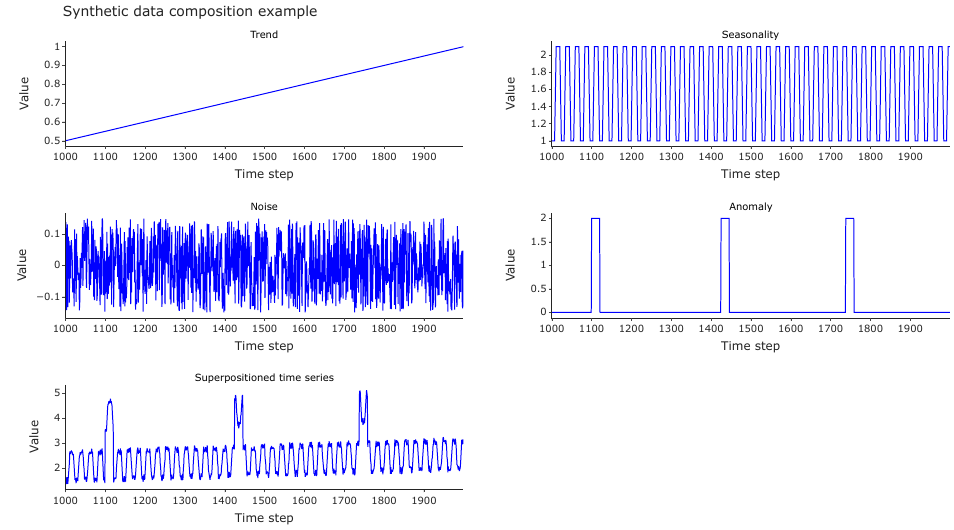
Figure 4. Example of a synthetic time series. Table 2. Overview of used parameter ranges for the synthetic time